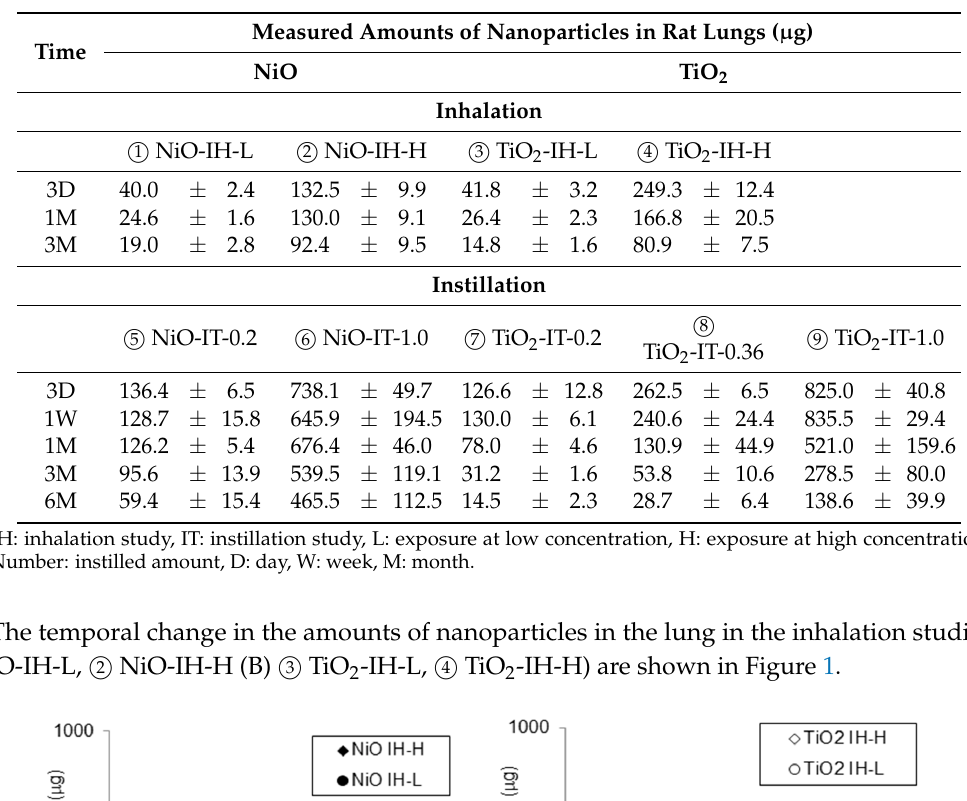
Table 1. Measured particle amounts in rat lungs.